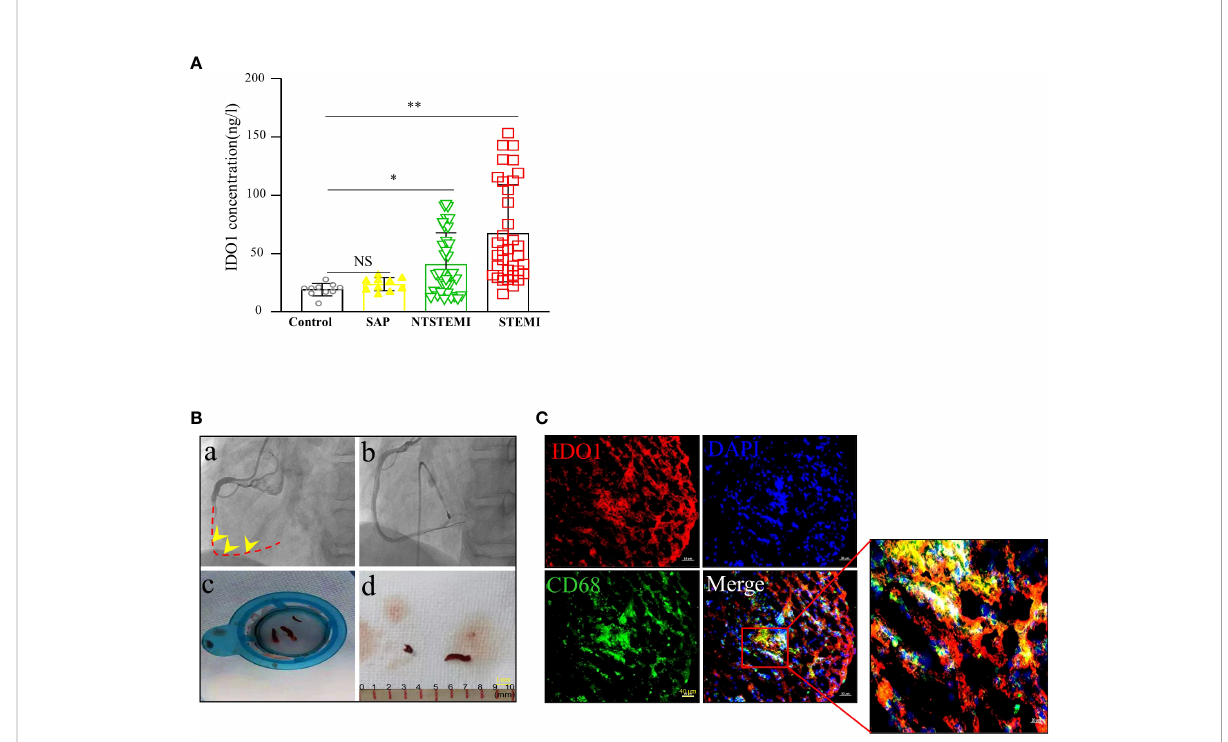
FIGURE 2 High IDO1 and Kyn expression in thrombi of coronary arteries. (A) Distribution of IDO1 plasma level in control subjects(n=10), SAP patients (n=10), NTSTEMI patients(n=34) and STEMI patients(n=35), NS, not signi fi cant, *P<0.05 vs con subjects, **P<0.01 vs con subjects. (B) Coronary artery thrombi were obtained from the STEMI patients presenting to the cardiac catheterization laboratory. (a) Angiogram demonstrating thrombotic occlusion (arrow) of the right coronary artery in the STEMI patient, dashed line indicated the occluded vessels. (b) Final angiogram showed a widely patent of the right coronary artery with no signi fi cant luminal narrowing. (c, d) Thrombectomy catheter aspirate after passage through fi lter showing coronary artery thrombi (arrow) (scale bar, 1mm). (C) Representative immuno fl uorescence staining for CD68 and IDO1 in the coronary artery thrombi of STEMI patients. Immuno fl uorescence image showing CD68 + (red) macrophages and IDO1 (green) expression; merged image was included. Nuclei was counterstained with DAPI. Co-localization of IDO1 and CD68 + macrophages was depicted in the overlay. The square indicated the macrophage cells expressing IDO1(scale bar, 40 m